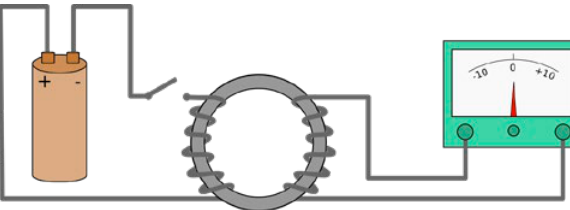
Figure 16. Scheme of the experiment on electromagnetic induction by Faraday, August 29, 1831. When the circuit on the left is closed, the presence of an induced current in the circuit on the right is observed, as long as the first does not reach the steady state value when the current in the second circuit disappears. In fact, the mag- netic field flux inside the soft iron ring around which the two fila- ments are wrapped changes over time after closing the first circuit. The same phenomenon is observed after opening again the left cir- cuit, in which case the flux of the magnetic field decreases. There- fore, induction, differently from the electrostatic interaction, is a dynamic phenomenon